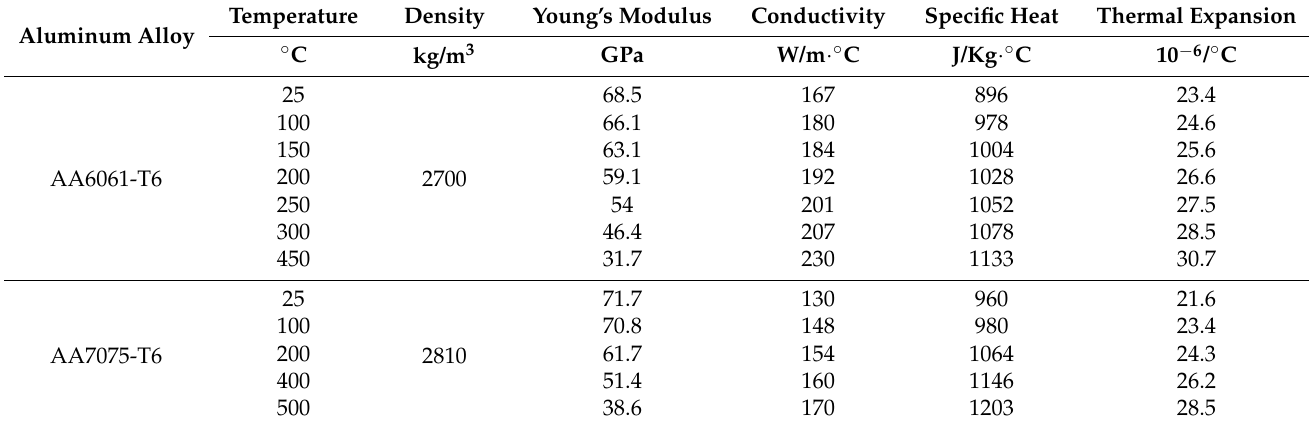
Table 4. Mechanical and thermal properties for AA7075-T6 and AA6061-T6 alloys [53,54]. Aluminum